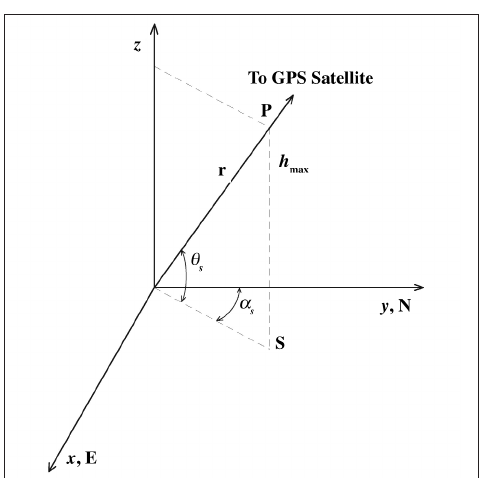
Fig. 4. Schematic representation of the transionos- pheric sounding geometry. The axes z , y and x are di- rected, respectively, zenithward, northward (N) and eastward (E); P – point of intersection of Line-Of- Sight (LOS) to the satellite with a horizontal plane at the height of the maximum of the ionospheric F 2 re- gion ( h max ); S – subionospheric point; Θ s and α s – el- evation and azimuth of the direction r along LOS to the